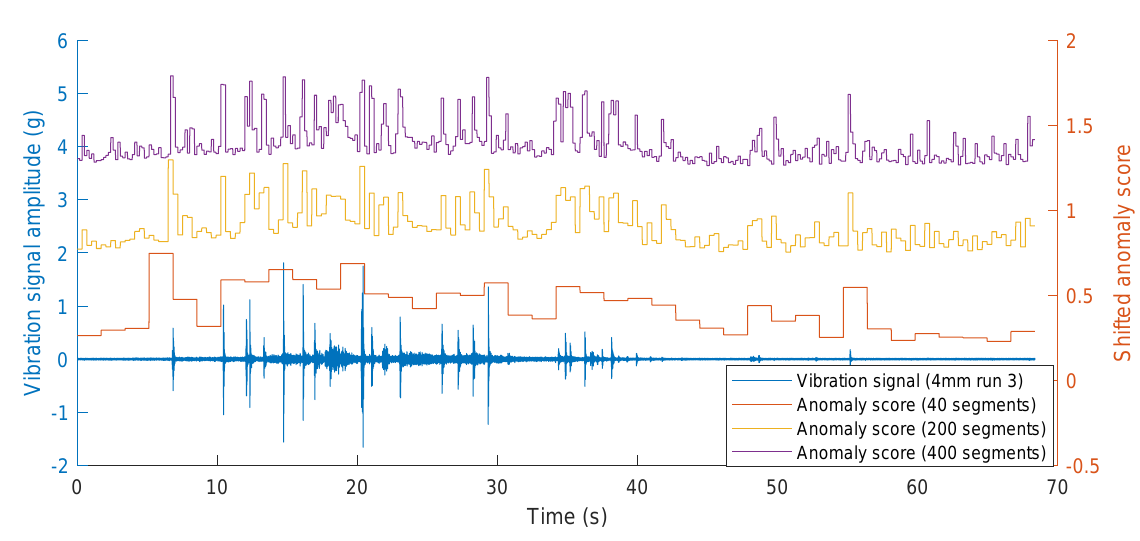
Figure 7. Example anomaly score for a no-squat case with different segment